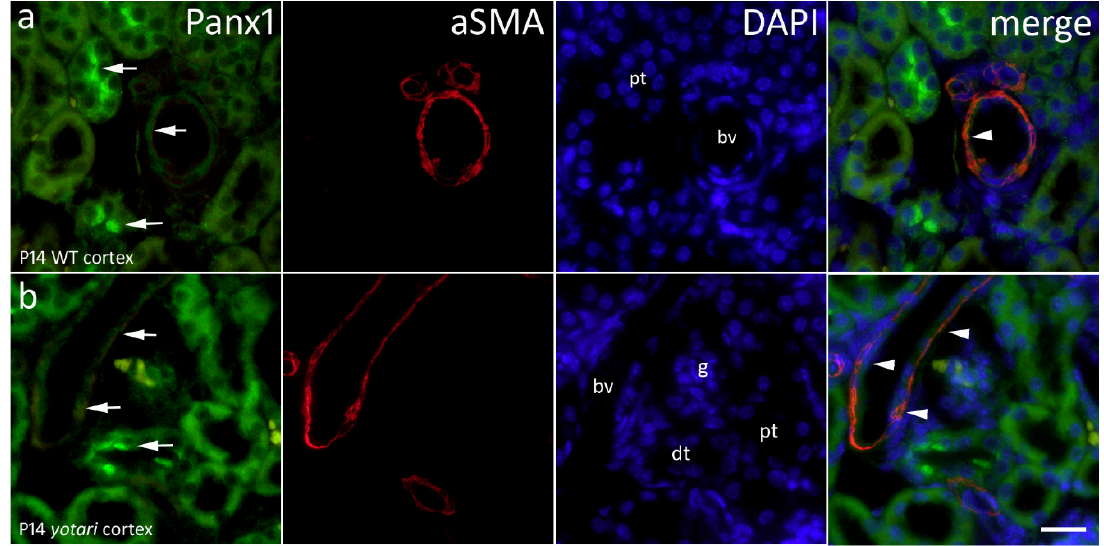
Figure 6. Immunofluorescence staining of postnatal yotari ( b ) and wild type ( a ) mouse kidneys with the Panx1 marker and co-expression of Panx1 and aSMA with DAPI nuclear staining. Expression of Panx1 (arrows), blood vessels (bv), glomeruli (g), proximal convoluted (pt) and distal convoluted tubules (dt). Co-expression of Panx1 and aSMA (arrowheads) can be seen on merged photographs. Autofluorescence of nephron tubules and erythrocytes (*), not to be mistaken with positive immunofluorescence staining. Scale bar is 20 μ m, refers to all images.